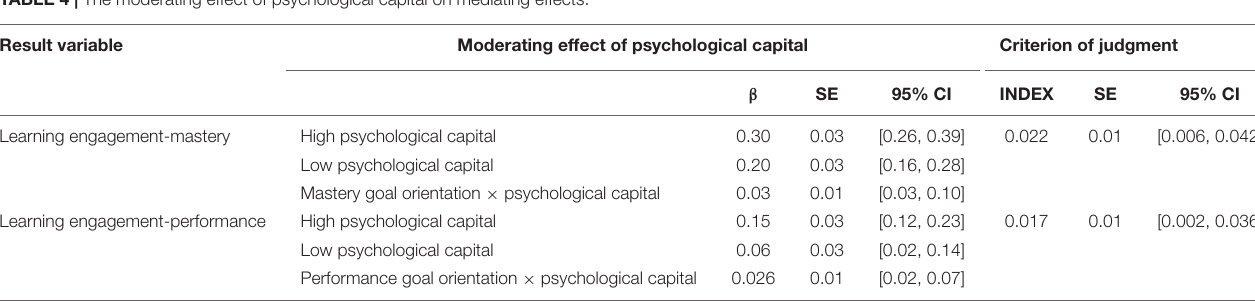
FIGURE 2 | The mediating effect of psychological capital and achievement goal orientation between social mobility and learning engagement. ∗∗ p < 0.01, ∗∗∗ p < 0.001. TABLE 4 | The moderating effect of psychological capital on mediating